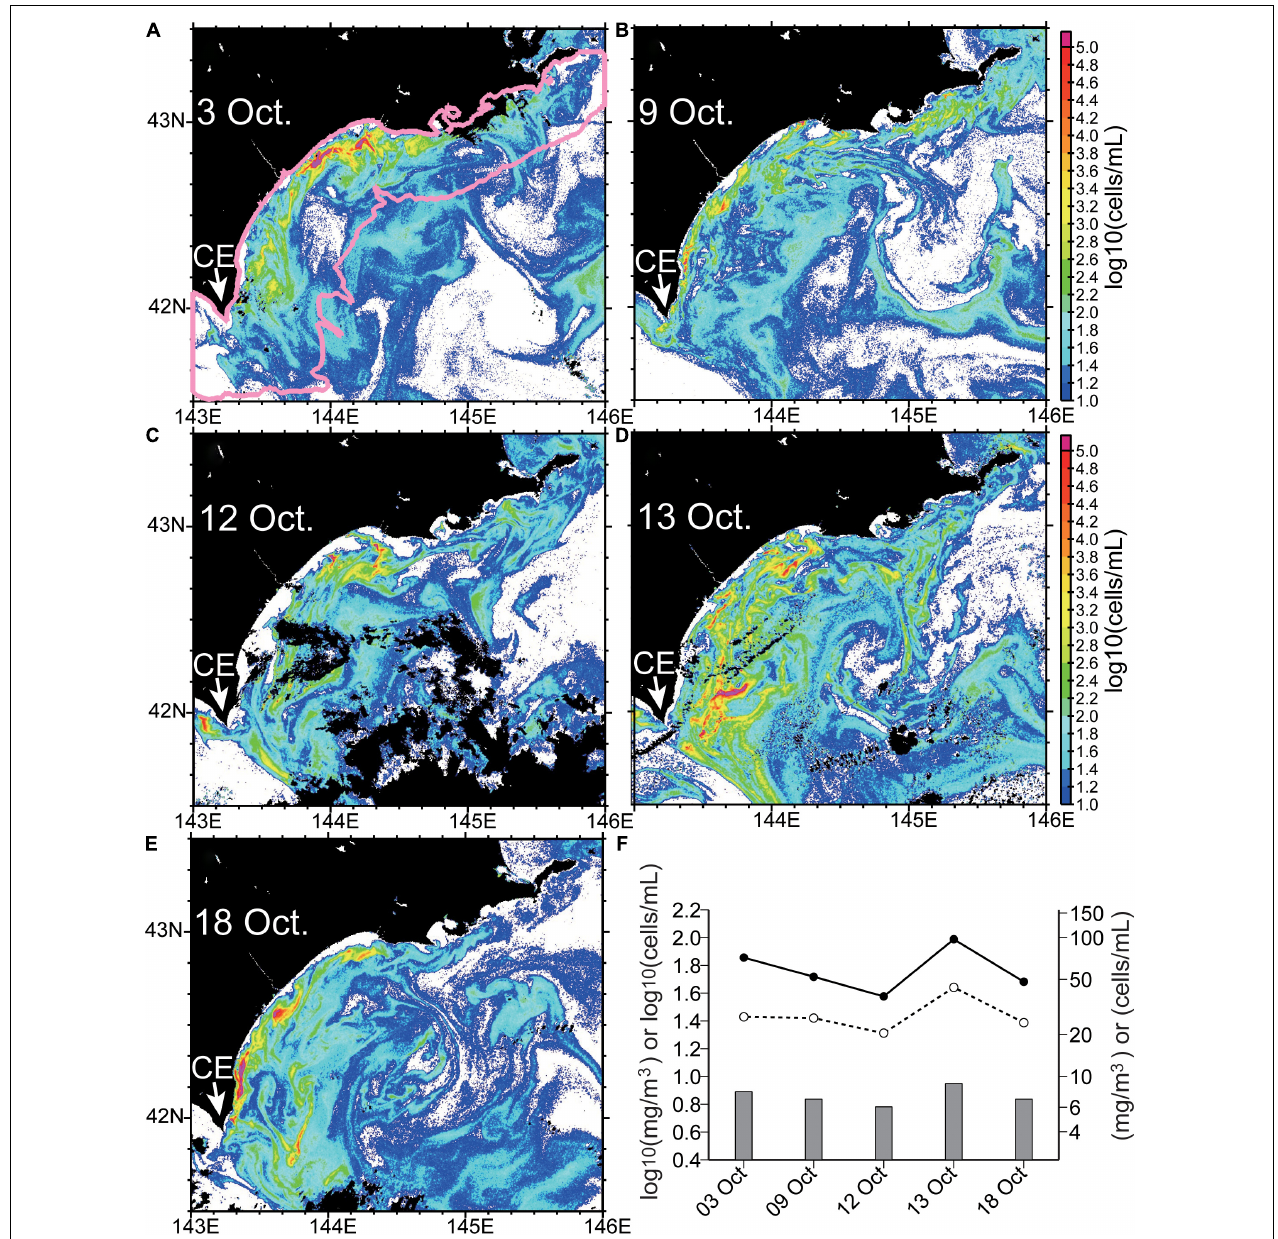
FIGURE 13 | (A–E) The same as Figure 12C (units: log 10 [cells mL − 1 ]), but for (A) 3, (B) 9, (C) 12, (D) 13, and (E) 18 October, 2021. CE, Cape Erimo. (F) Karenia abundance (lines) and chlorophyll- a concentration (bars) averaged over shelf–slope regions with water depth < 1,000 m [i.e., the pink polygon in panel (A) ] and derived from red-band difference (dashed line, open circles) and maximum line height (solid line, closed circles). Estimated chlorophyll- a concentrations were based on maximum line height and a regression equation ( Table 1 ).